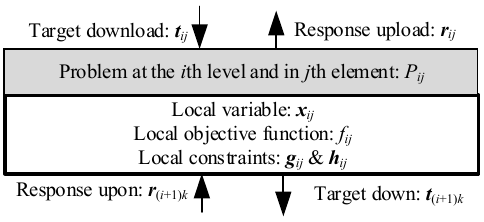
Figure 3. Information communication of ATC method in one element.